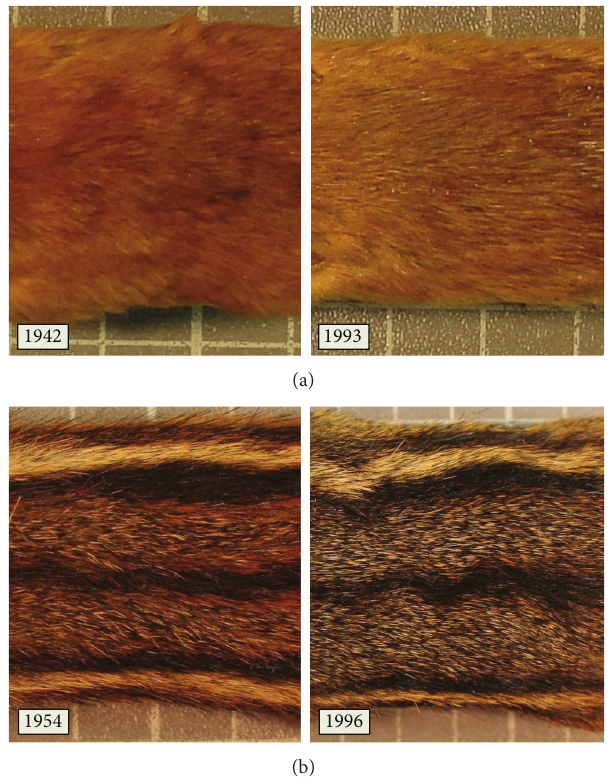
Figure 3: Comparison of representative older and newer specimens of golden mice (a) and chipmunks (b), cropped to show the region measured.